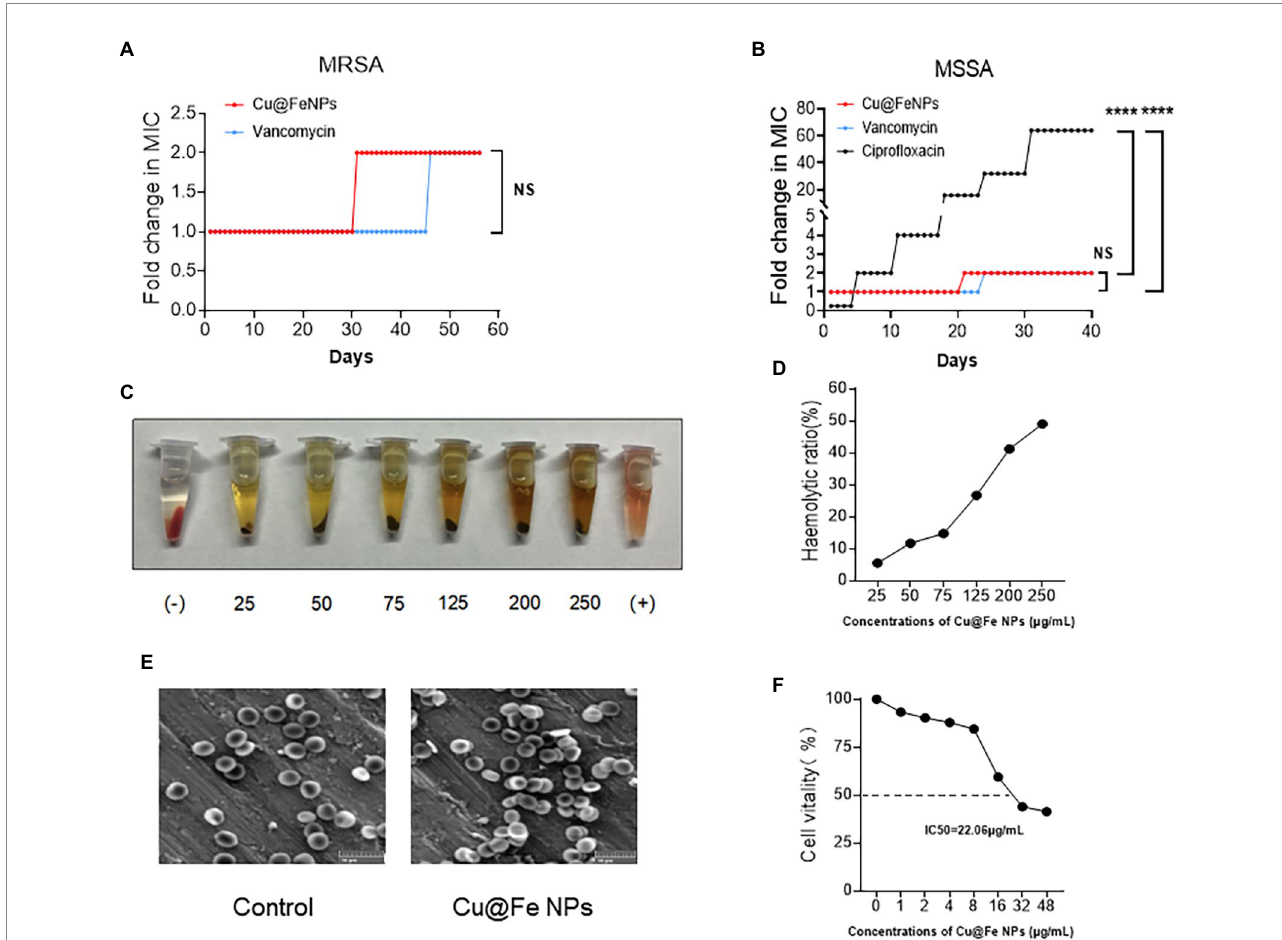
FIGURE 2 Cu@Fe NPs have excellent antibacterial effect and drug safety. (A , B) Determination of MIC resistance of Cu@Fe NPs to MSSA and MRSA in successive passages. (C) Representative image of the haemolytic response of mRBCs to different concentrations (0–250 μ g/mL) of Cu@Fe NPs. (D) The haemolytic ratio of mRBCs. (E) Typical SEM images of mRBCs treated with PBS or 3.84 μ g/mL Cu@Fe NPs. Scale bar, 10 μ m (200×). (F) Percentage changes in the cell viability of HSF-1 against different concentrations (0–48 μ g/mL) of Cu@Fe NPs. (A , B) Two-way ANOVA with Holm-Sidak’s multiple comparisons test. Data are expressed as mean ± SEM. NS versus Vancomycin group. **** p < 0.0001 Ciprofloxacin